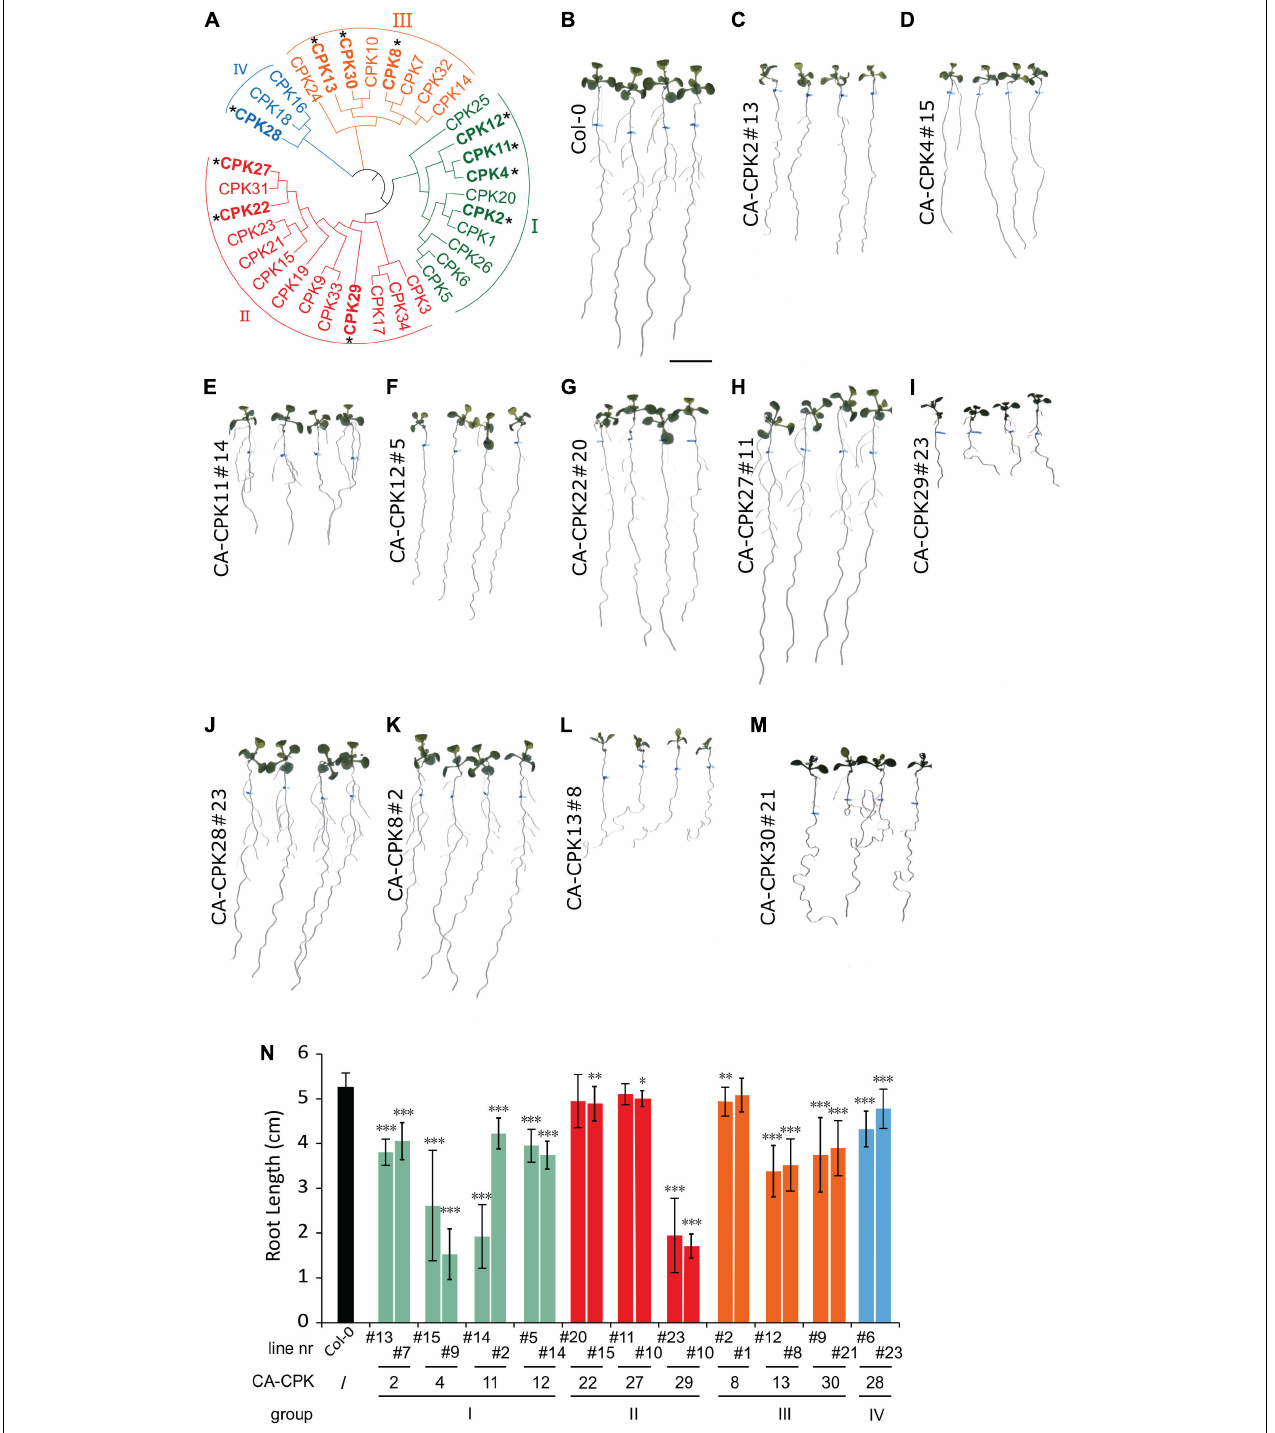
FIGURE 1 | Phenotypic screen of constitutive active CPKs. (A) Phylogenetic tree of the Arabidopsis CPK family, with indication of the four main subgroups (I-IV). CPKs indicated with an asterisk were analyzed via stable overexpression lines. (B–M) Overview of macroscopic phenotypes of CA-CPK lines relative to WT (Col-0). Seeds were grown for 5 days on 1/2 × MS medium then transferred to medium supplemented with 2.5 µ M β -estradiol for another 7 days. Scale bar = 1 cm. (N) Quantification of root length for indicated CA-CPK lines. Data are represented as the mean ± SD of at two independent replications. n ≥ 12 for all lines, except for CPK12#14 ( n = 6) and CA-CPK22#20 ( n = 7). Asterisk indicates significant difference (Unpaired Student’s t -test; ∗ P ≤ 0.05, ∗∗ P ≤ 0.01, ∗∗∗ P ≤ 0.001) between transgenic lines and WT (Col-0) plants.